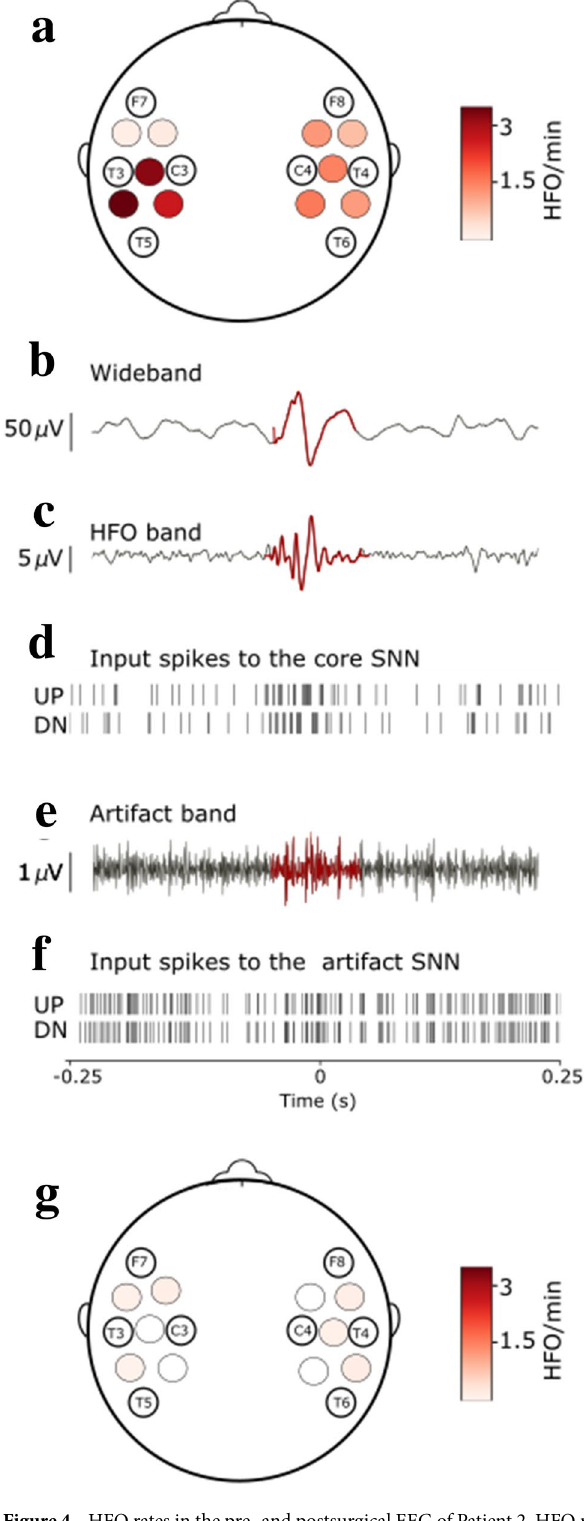
Figure 4. HFO rates in the pre- and postsurgical EEG of Patient 2. HFO rates and their localization in pre- ( a ) and postsurgical ( g ) EEG after the second surgery of Patient 2. Example of an HFO detected by the EEG SNN in the presurgical EEG in the bipolar channel T3-T5 ( b – f ). We filtered the wideband signal ( b ) in the ripple band (80–250 Hz) ( c ) and converted it to spikes ( d ). These spikes are the input to the core SNN for EoI detection. ( e ) We filtered the same signal in the 500–900 Hz band and converted it to spikes ( f ). These spikes are the input to the artifact detection SNN for artifact detection. Patient 2 underwent resective epilepsy surgery within the left hemisphere and achieved seizure freedom (follow-up 67 months). The EEG SNN found a 3.5 HFO/min maximum mean HFO rate in the presurgical and 0.2 HFO/min in the postsurgical recordings. The decrease of HFO rate after surgery in this patient mirrored the decrease in seizure frequency from 180 seizures/month before surgery to postsurgical seizure